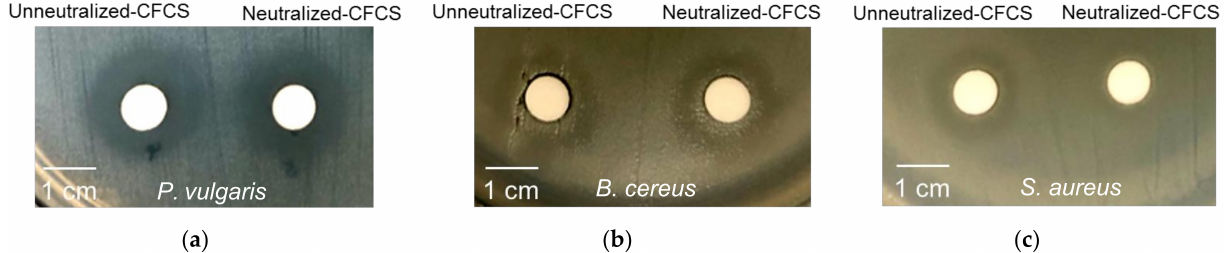
Figure 4. Antimicrobial activity of cell-free culture supernatant (CFCS) of E. hirae SX2 cultivated in MRS xylose against Proteus vulgaris ( a ), Bacillus cereus ( b ), and Streptococcus aureus ( c